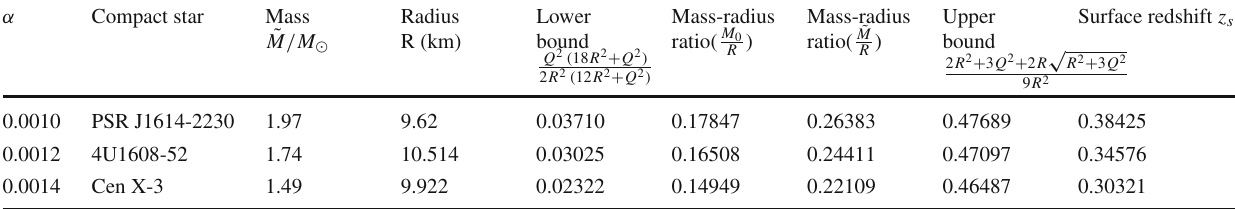
Table 2 Comparative study of lower bound, Mass-radius ratio, upper bound, compactness ( u = M eff / R ) and surface red-shift of the star for different values of α α Compact